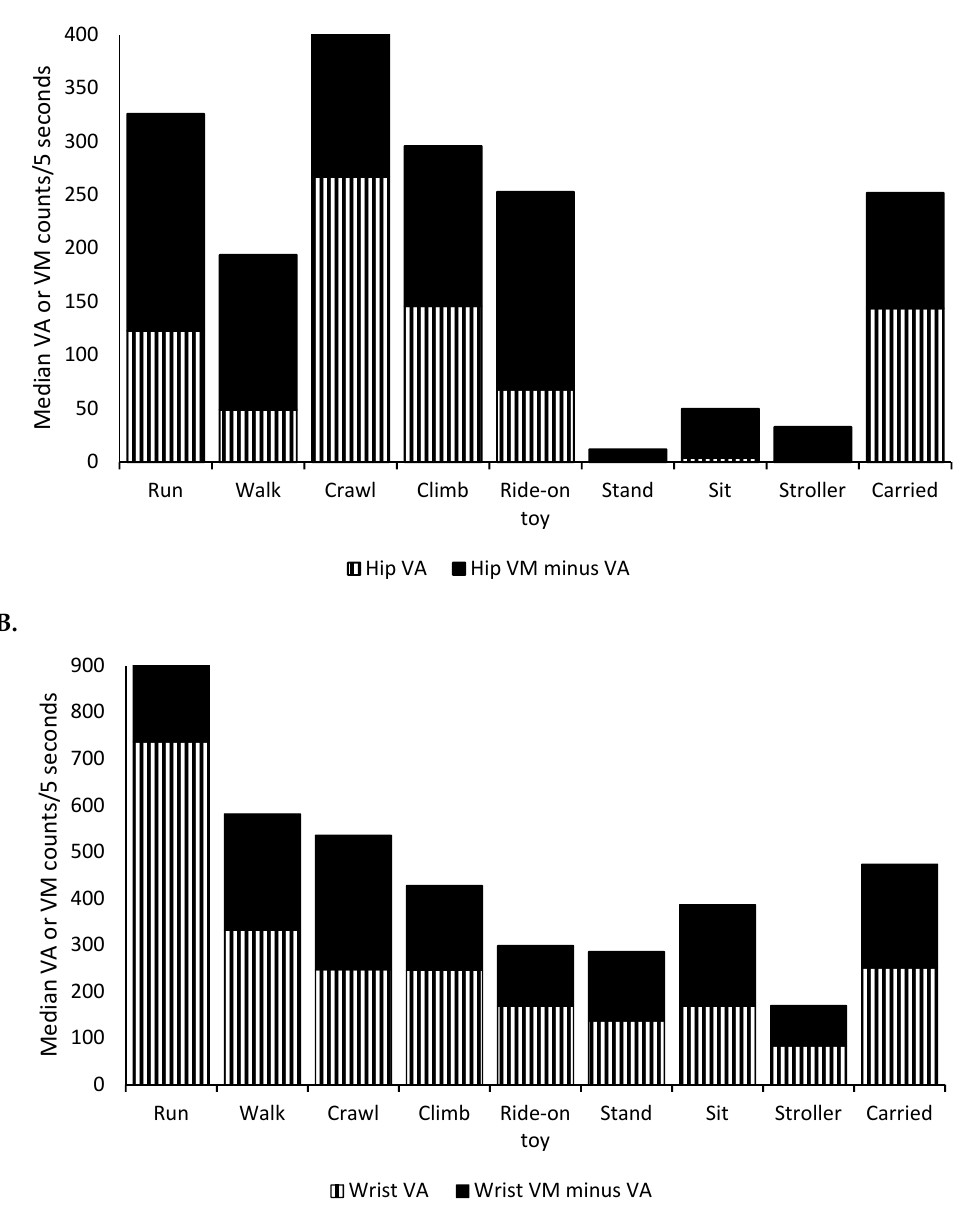
Figure 2. The medians of vertical axis (VA) and vector magnitude (VM) counts per 5 s for various behaviors in toddlers. ( A ) Hip-worn accelerometer counts, ( B ) wrist-worn accelerometer counts